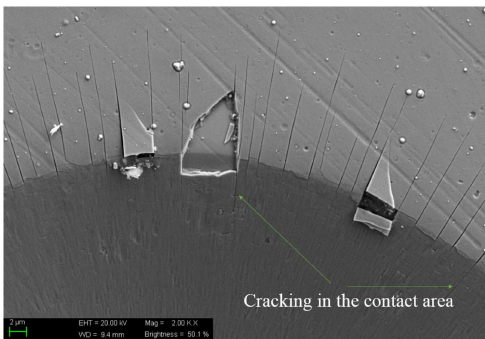
Figure 12. SEM observation of the indented surface of 2 µ m CrN coated M50 disks under a load of 15 N and temperature of 500 ◦